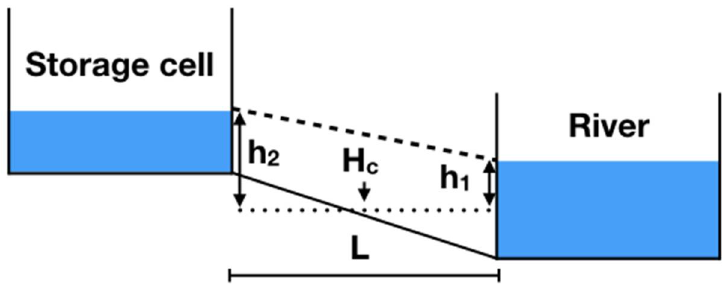
Figure 7. Sketch of the link between a river and a storage cell by an ideal channel. H c is the bottom elevation of the ideal channel, h 1 and h 2 are free surface elevation in the river and in the storage cell respectively.